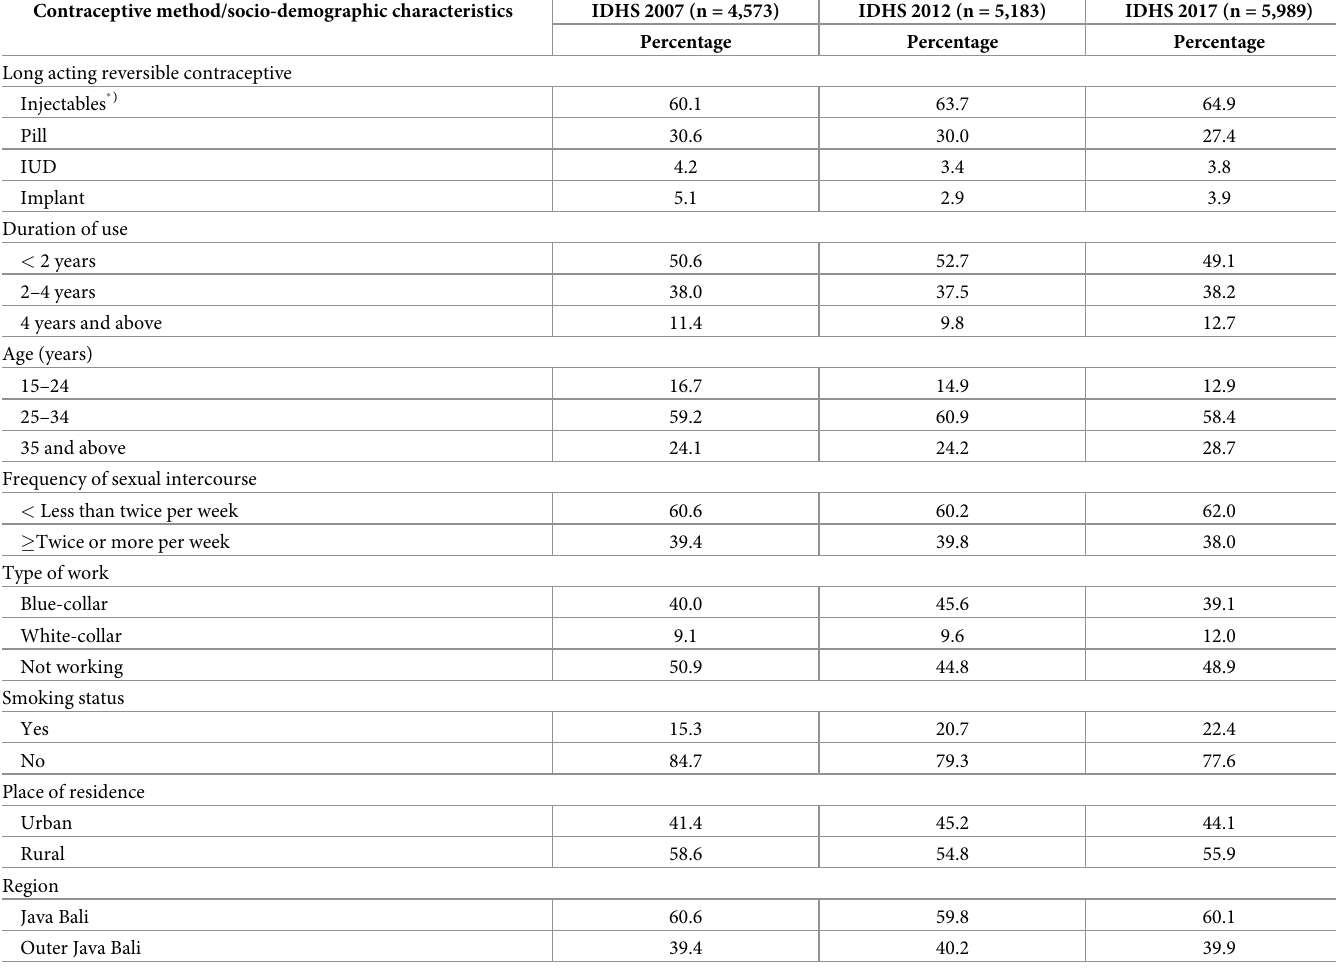
Table 1. Percentage distribution of women who discontinuing contraceptives due to desire to be pregnant according to the use of long-acting reversible contracep- tives and various socio-demographic characteristics. Indonesia 2007, 2012 and 2017. Contraceptive method/socio-demographic